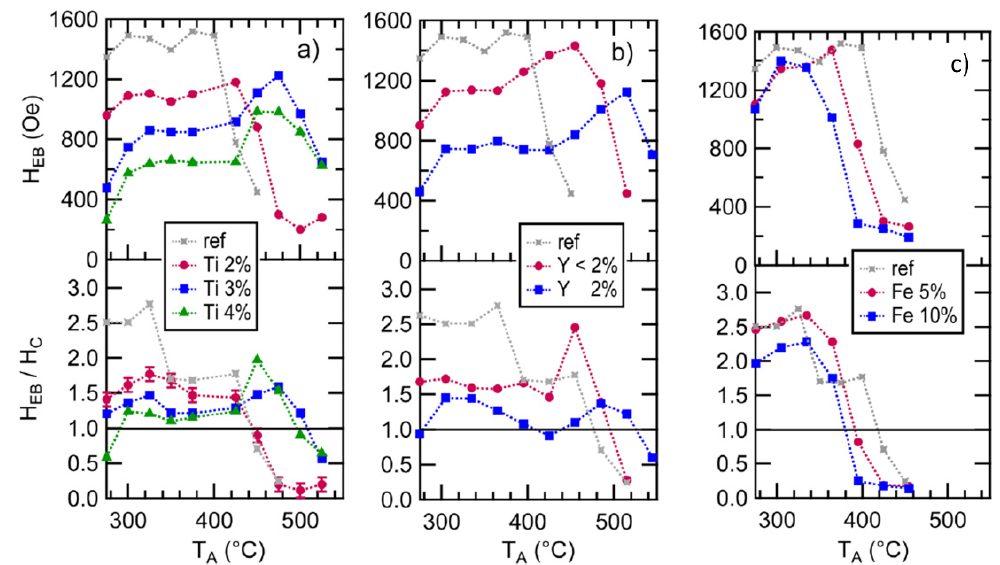
Figure 6. Exchange bias as a function of annealing temperature for different dopant elements: ( a ) Ti, ( b ) Y, ( c ) Fe. The reference measurement (ref) refers to an undoped sample. (Adapted from M. Dunz, Büker and M. Meinert, Journal of Applied Physics 124, 203, 902 (2018); doi:10.1063/1.5051584) [19].